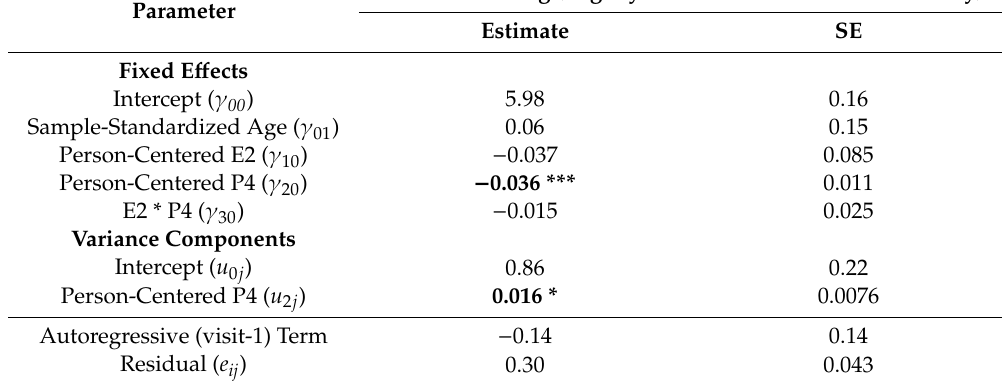
Table 3. Multilevel Regression Models Predicting Log High Frequency Heart Rate Variability (HFlog) from Estradiol (E2) and Progesterone (P4) in Study One ( N = 158